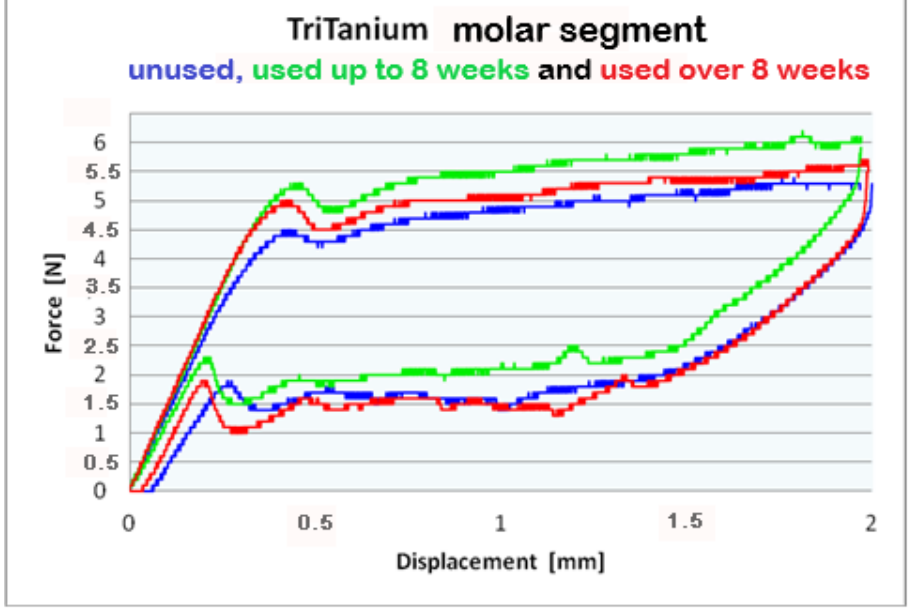
Figure 7. Combined force/deformation curve graphs for period G 0 (blue), G 1 (green) , G 2 (red), molar segment for the TriTanium ® archwire.